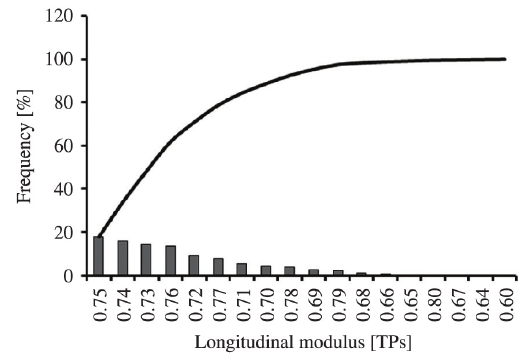
Figure 15. Pareto plot of defected CNT (12,0) with 5% defect density.